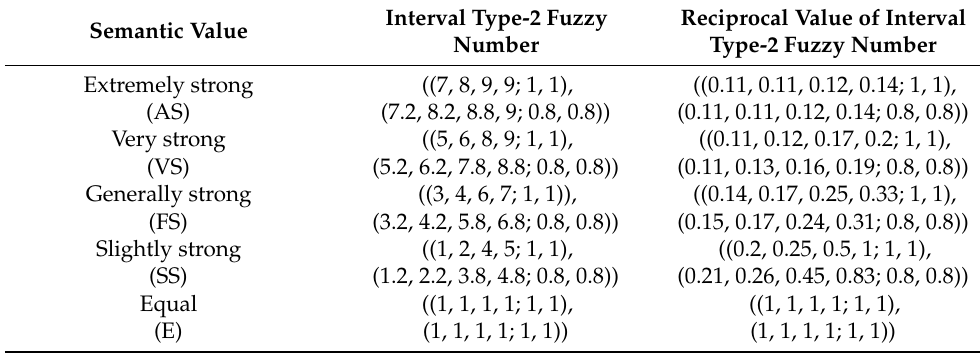
Table 2. The relationship between the semantic values and the interval type-2 fuzzy